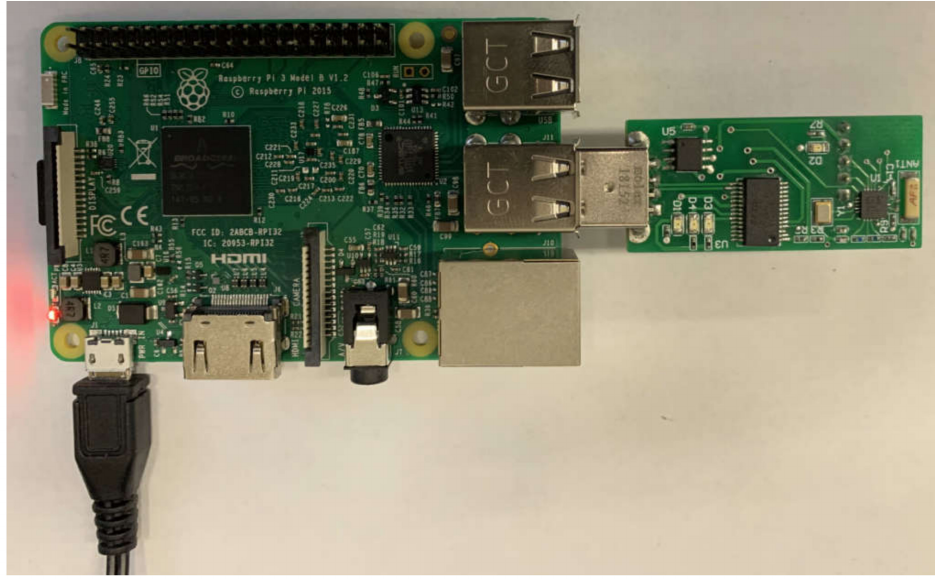
Figure 6. Data logger connected to the Raspberry Pi